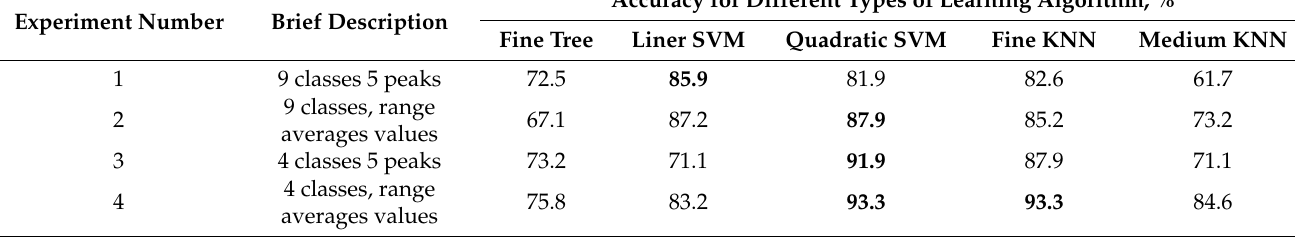
Table 2. Training results of ANS classifiers.